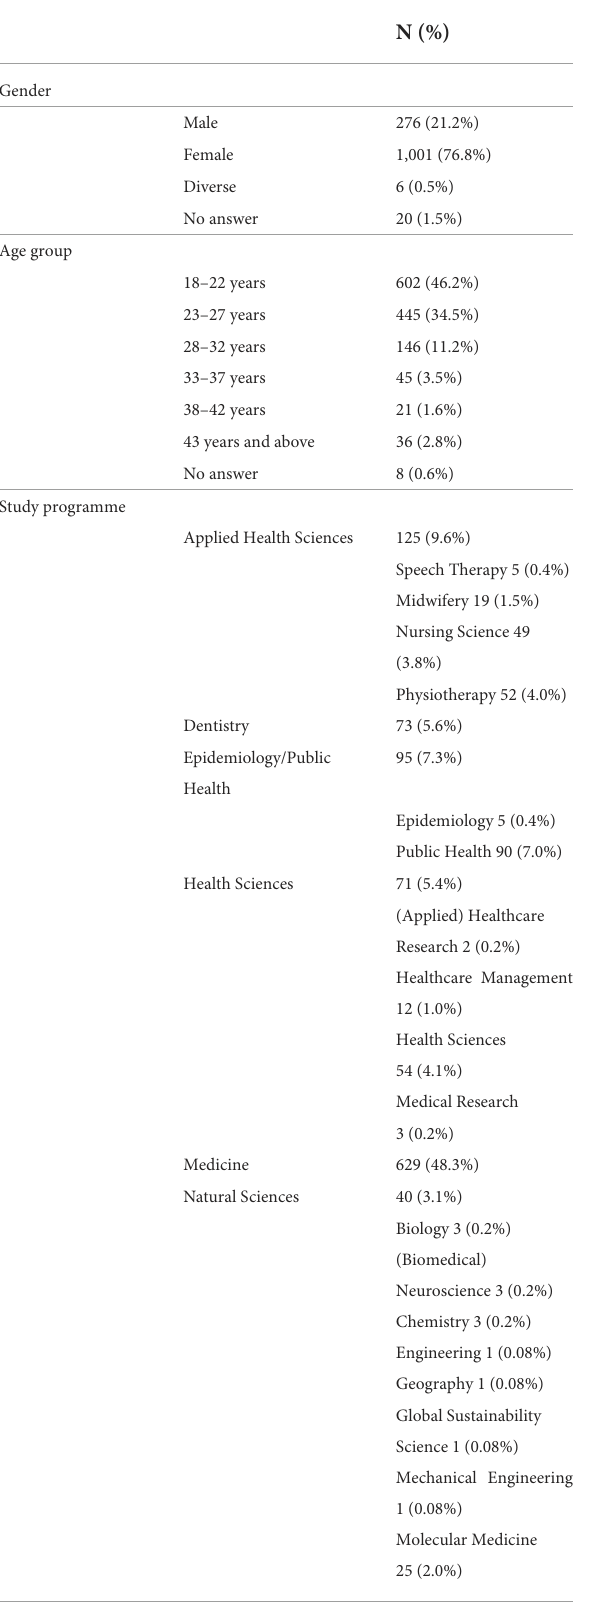
TABLE 1 Participant characteristics ( N =